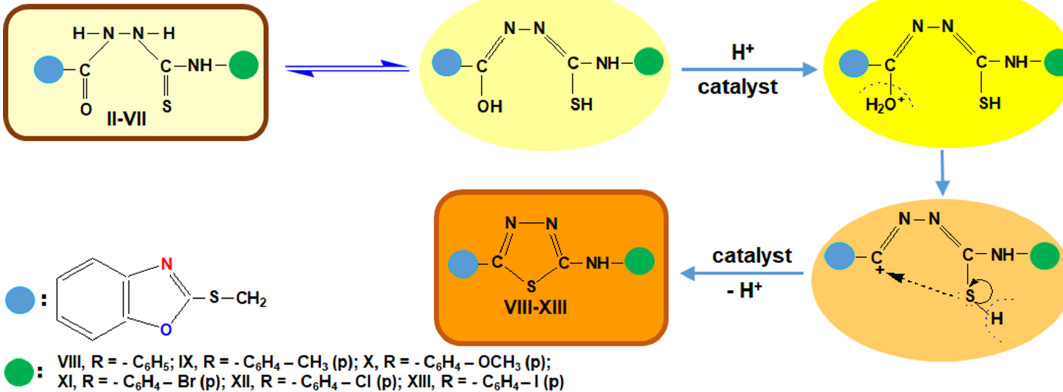
Figure 5. Intramolecular cyclization mechanism of reaction synthesis of 5-aryl-amino-2-substituted-1,3,4-thiadiazoles .